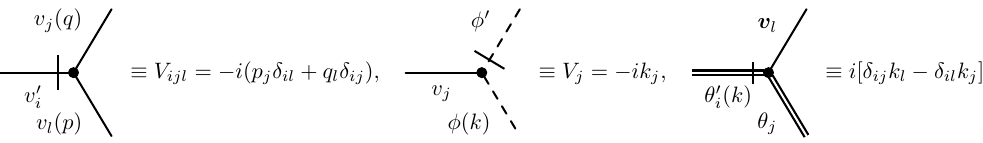
Figure 1. Graphical representation of all propagators of the model given by the quadratic part of the action (11).